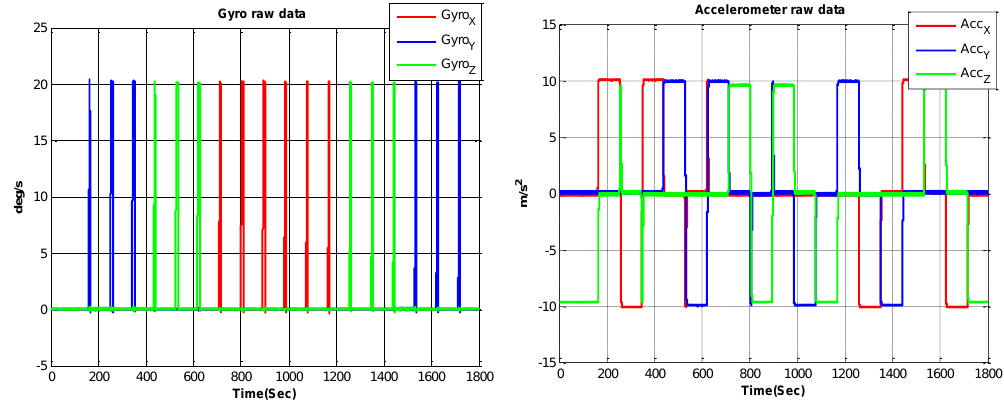
Figure 5. IMU raw